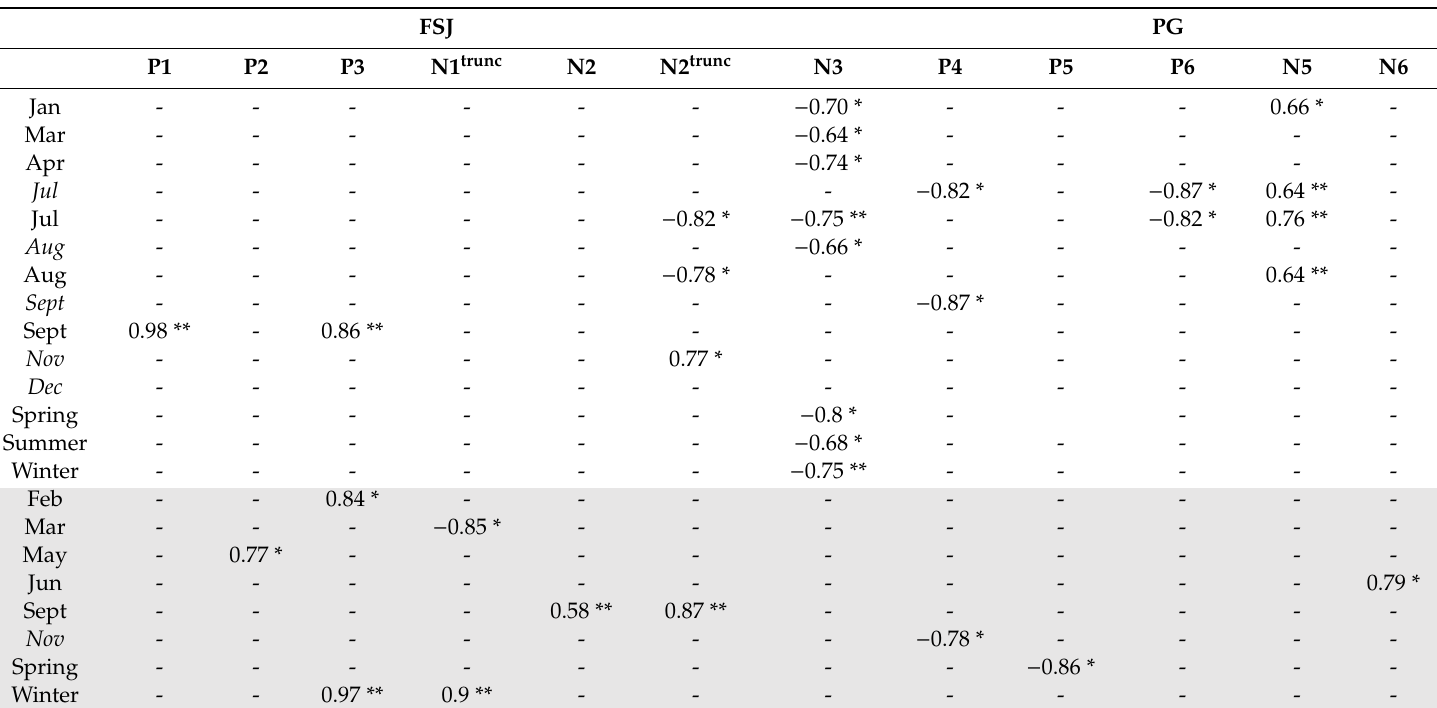
Table 3. Pearson’s correlation coe ffi cient between the current and previous (italics) average monthly and seasonal temperature ( ◦ C) (white) and precipitation (mm) (grey shading) and percent carbon for natural (N) and planted (P) stands surrounding the John Prince Research Forest (FSJ; N1–N3, P1–P3) and Prince